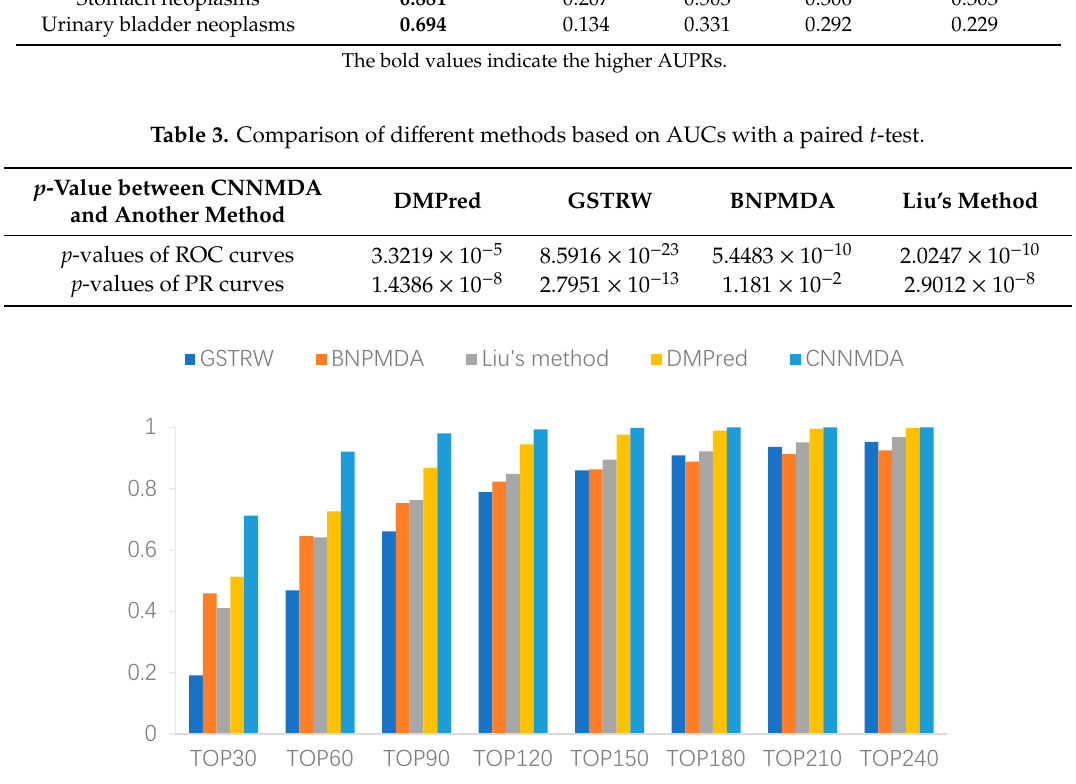
Table 2. Prediction results of CNNMDA and other four methods for 15 diseases in terms of the area under the precision–recall curve (AUPR).